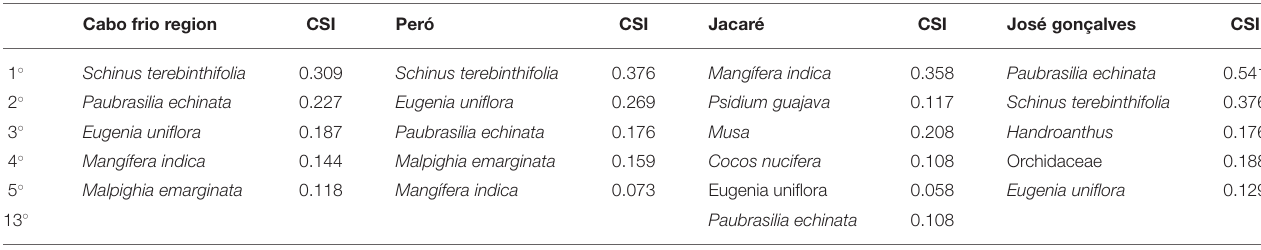
TABLE 3 | Cultural salience index (CSI) results among the interviewees in the municipalities of Cabo Frio (Peró and Jacaré) and Armação dos Búzios (José Gonçalves) in the state of Rio de Janeiro, Brazil. Cabo frio region